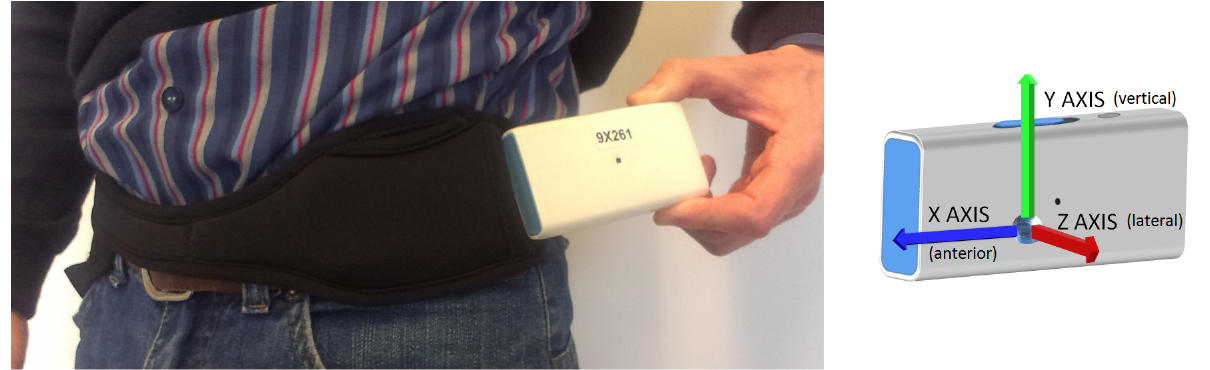
Figure 1. Portable inertial sensor and the neoprene belt where the sensor was